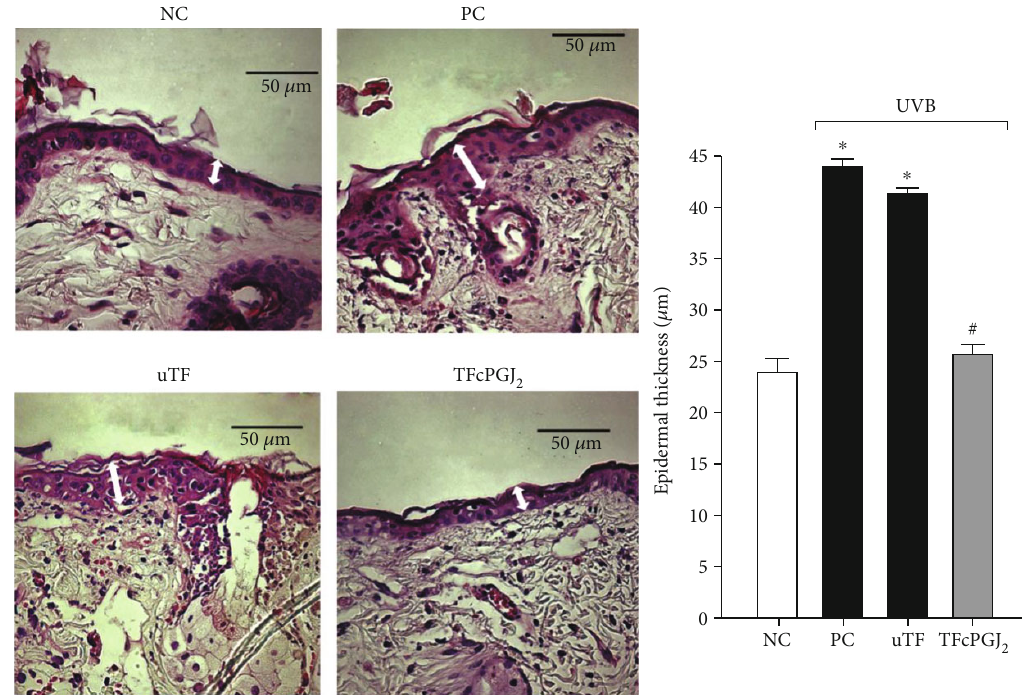
Figure 9: Topical formulation containing 15d-PGJ (TFcPGJ ) inhibits UVB irradiation-induced epidermal thickening. Epidermal 2 2 thickness (double-edge white arrows) was evaluated using hematoxylin and eosin-stained slices of skin samples collected 12h after the end of irradiation. Stained slices were examined using light microscopy at 40x magni fi cation. NC: negative control; PC: positive control; uTF: unloaded topical formulation. Bars are means ± SEM of 6 mice per group and are representative of two separate experiments. One- way ANOVA followed by Tukey ’ s test. ∗ p < 0 : 05 versus the negative control group; # p < 0 : 05 versus UVB-stimulated compared groups.